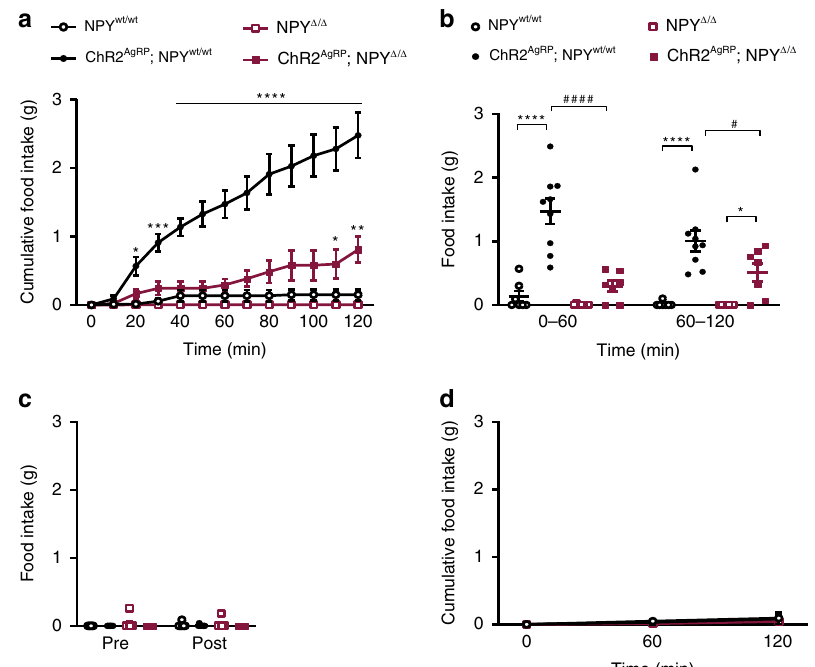
Fig. 3 NPY is necessary for the acute feeding response upon optogenetic activation of AgRP neurons. a , b Cumulative and total food intake upon AgRP neuronal activation in the presence and in the absence of NPY ( n = 7 mice for NPY wt/wt , NPY Δ / Δ and ChR2 AgRP ; NPY Δ / Δ , and n = 9 mice for ChR2 AgRP ; NPY wt/wt ). c Food intake one hour prior to light illumination of the ARC (pre) and one hour after lasers were turned off (post) is similar in all genotypes ( n = 7 mice for NPY wt/wt , NPY Δ / Δ and ChR2 AgRP ; NPY Δ / Δ , and n = 9 mice for ChR2 AgRP ; NPY wt/wt ). d Cumulative food intake in the absence of light illumination ( n = 4 mice for NPY wt/wt and ChR2 AgRP ; NPY Δ / Δ , n = 3 mice ChR2 AgRP ; NPY wt/wt and n = 5 mice for NPY Δ / Δ ). Data are shown as mean ± s.e.m. Statistical analysis is represented by * p ≤ 0.05, *** p ≤ 0.001, **** p ≤ 0.0001, # p ≤ 0.05, and #### p ≤ 0.0001 as determined by two-way ANOVA followed by Tukey post hoc test. # represents comparisons between NPY-expressing and NPY-de fi cient animals. Source data are provided as a Source Data fi